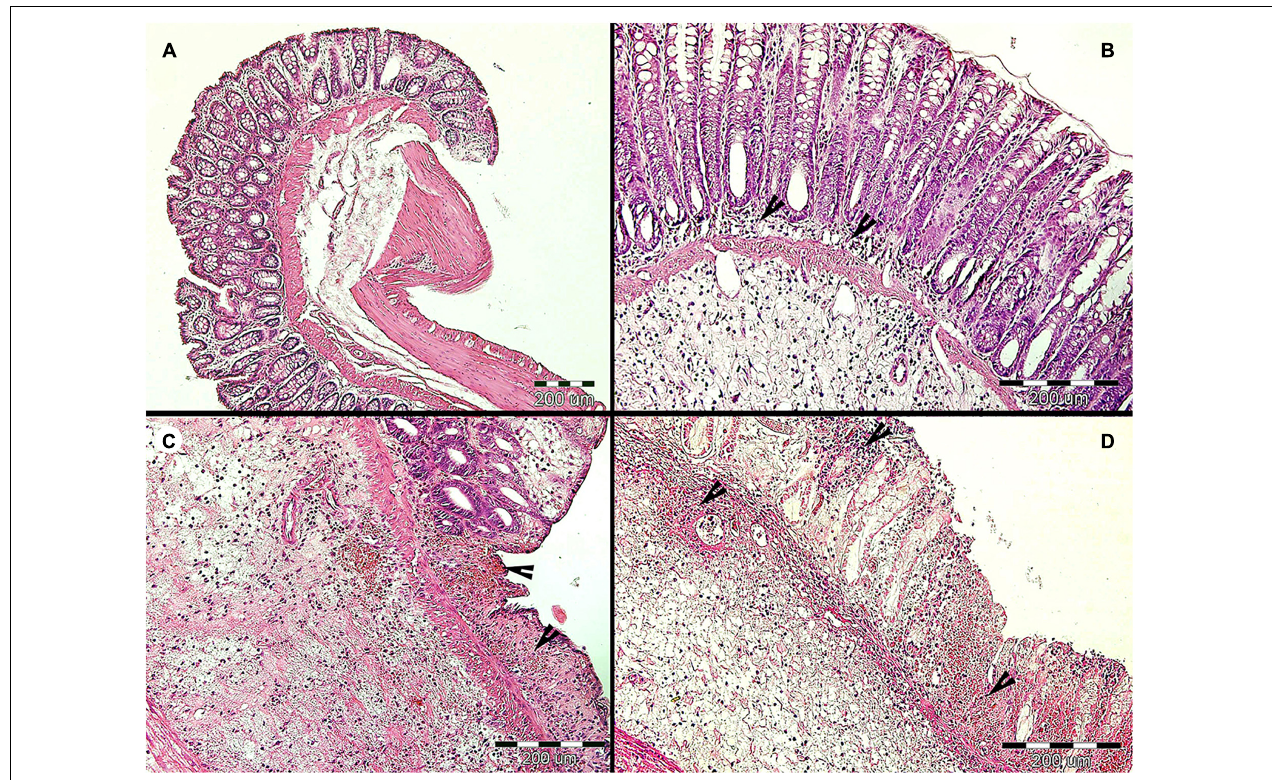
FIGURE 6 | Histopathological examination of the large intestine of rats during the long-term Blastocystis ST3 colonization and after the DNBS colitis induction. (A) Representative cross section of the large intestine of the control rats (i.e., non-colonized) before colitis induction on Day 85 (similar results were found on Day 32 which is not displayed here). (B) Representative cross section of the large intestine of the colonized rats before colitis; there was found the moderate lymphoplasmacytic inflammation (indicated by black arrows) on Days 32 and 85. (C,D) representative cross sections of the large intestine from control (C) and colonized (D) rats after colitis induction; there was revealed the chronic ulcerative colitis (indicated by black arrows) in both groups on Days 87 and 88 while the second day post colitis induction (Day 88) in colonized rats the inflammation was macroscopically milder and more localized (for details see Figure 5